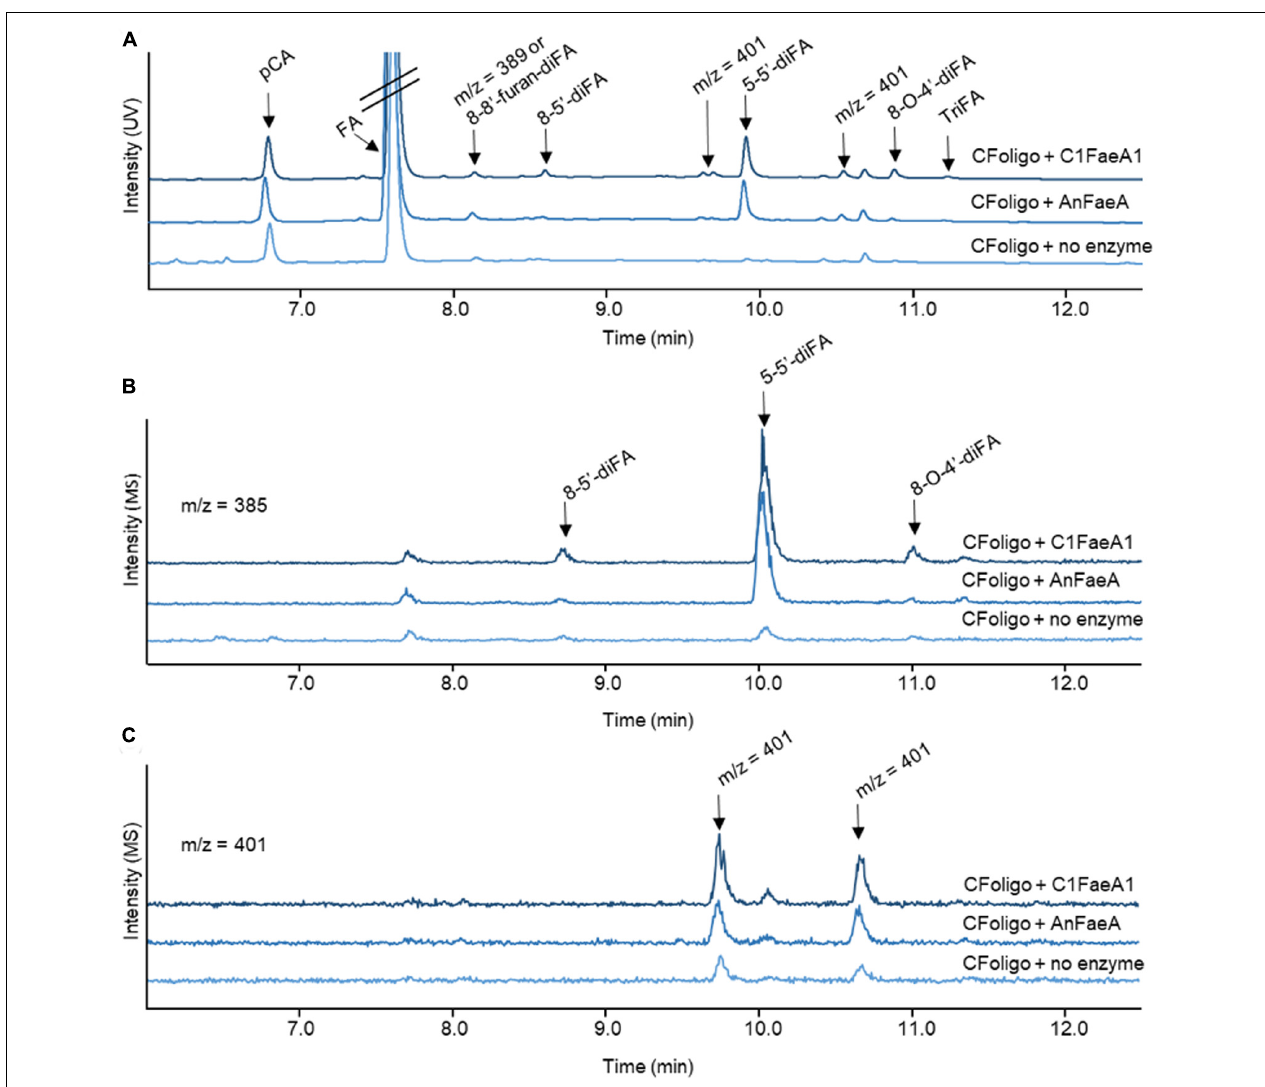
FIGURE 3 | RP-UHPLC-UV-ESI-MS/MS elution profiles for corn fiber oligomers (CFoligo) incubated with FAEs. CFoligo was incubated with either C1FaeA1 or AnFaeA, and without FAE. (A) Elution profile based on UV (310 nm) showing the release of ferulic acid (FA); p -coumaric acid ( p CA), diferulic acids (diFAs) and triferulic acids (triFAs) from CFoligo after the incubation with FAEs. (B,C) Elution profile of diferulic acids (diFAs) corresponding to the m/z 385 and 401, respectively. The m/z values represent the mass loss of 1 Da (MS operation in negative